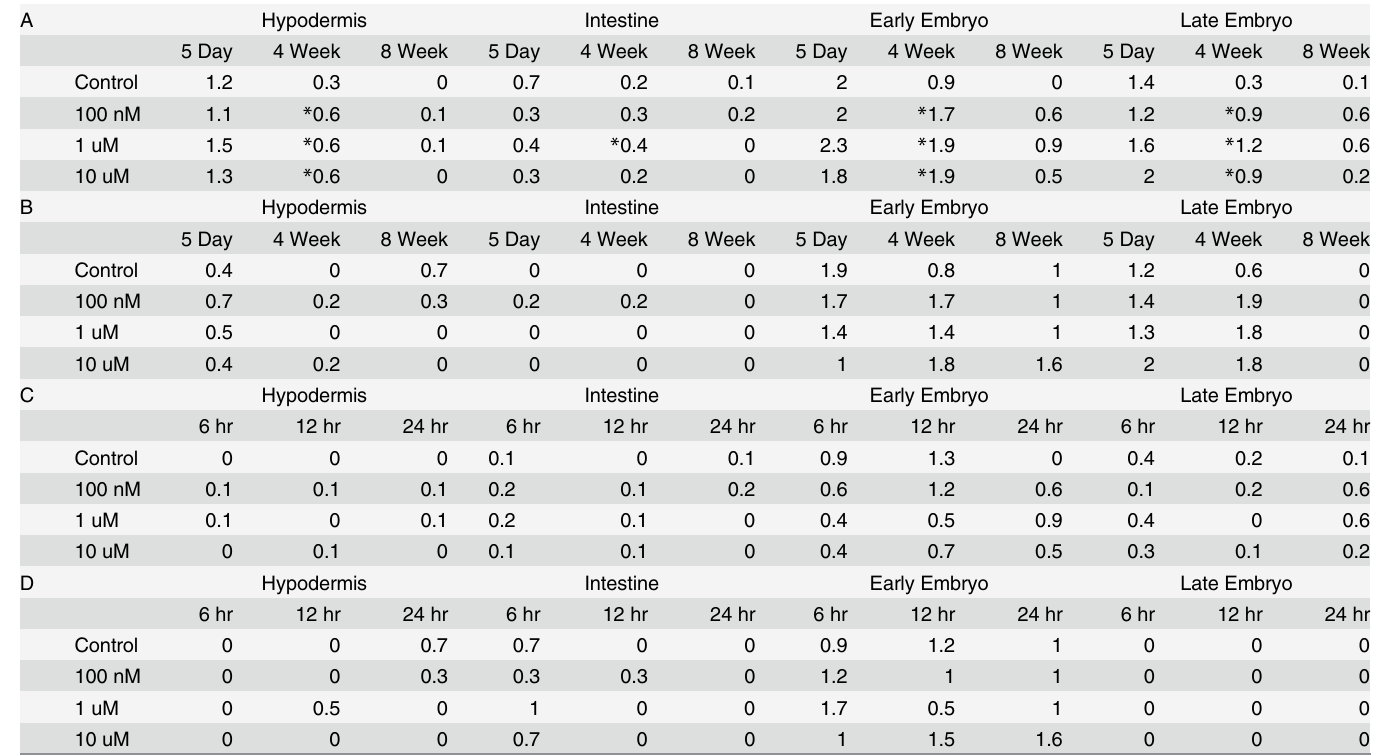
Table 1. Tissue damage score following recovery of FLBZ-exposed B . malayi females from na ï ve jirds. A, B. Worms incubated for 24 hr prior to trans- plantation and recovered from jirds for 5 days, 4 weeks or 8 weeks after. Data is a combination of two experiments. In experiment one worms transplanted into each of three jirds for all treatment groups were maintained for 5 days or 4 weeks. Worms transplanted into each of three jirds per treatment group in experiment two were maintained for 4 weeks or 8 weeks. The 4 week data were combined for presentation purposes. A minimum of 25 worms were assessed histologically C, D. Worms incubated for 6, 12, or 24 hr prior to recovery at 8 weeks. Worms were transplanted into each of three jirds per treatment group, fol- lowing the appropriate duration of in vitro exposure to FLBZ. The number of worms assessed histologically ranged from 11 to 39. Damage scored as